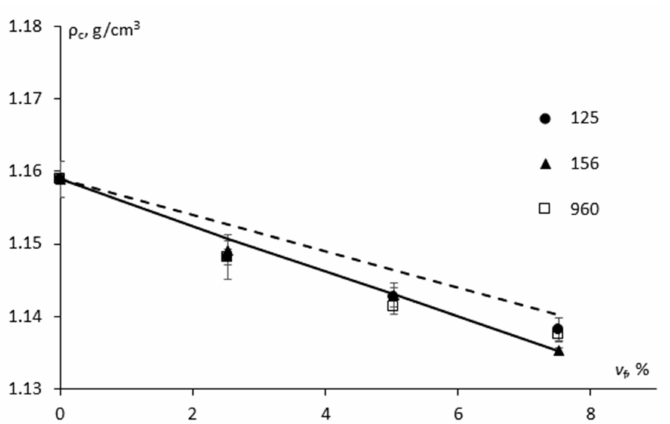
Figure 2. The density of the epoxy modified with different additives containing CSR nanoparticles (indicated on the graph) as a function of filler volume fraction (symbols—experimental data, dashed and solid lines—estimation by Equations (8) and (10),